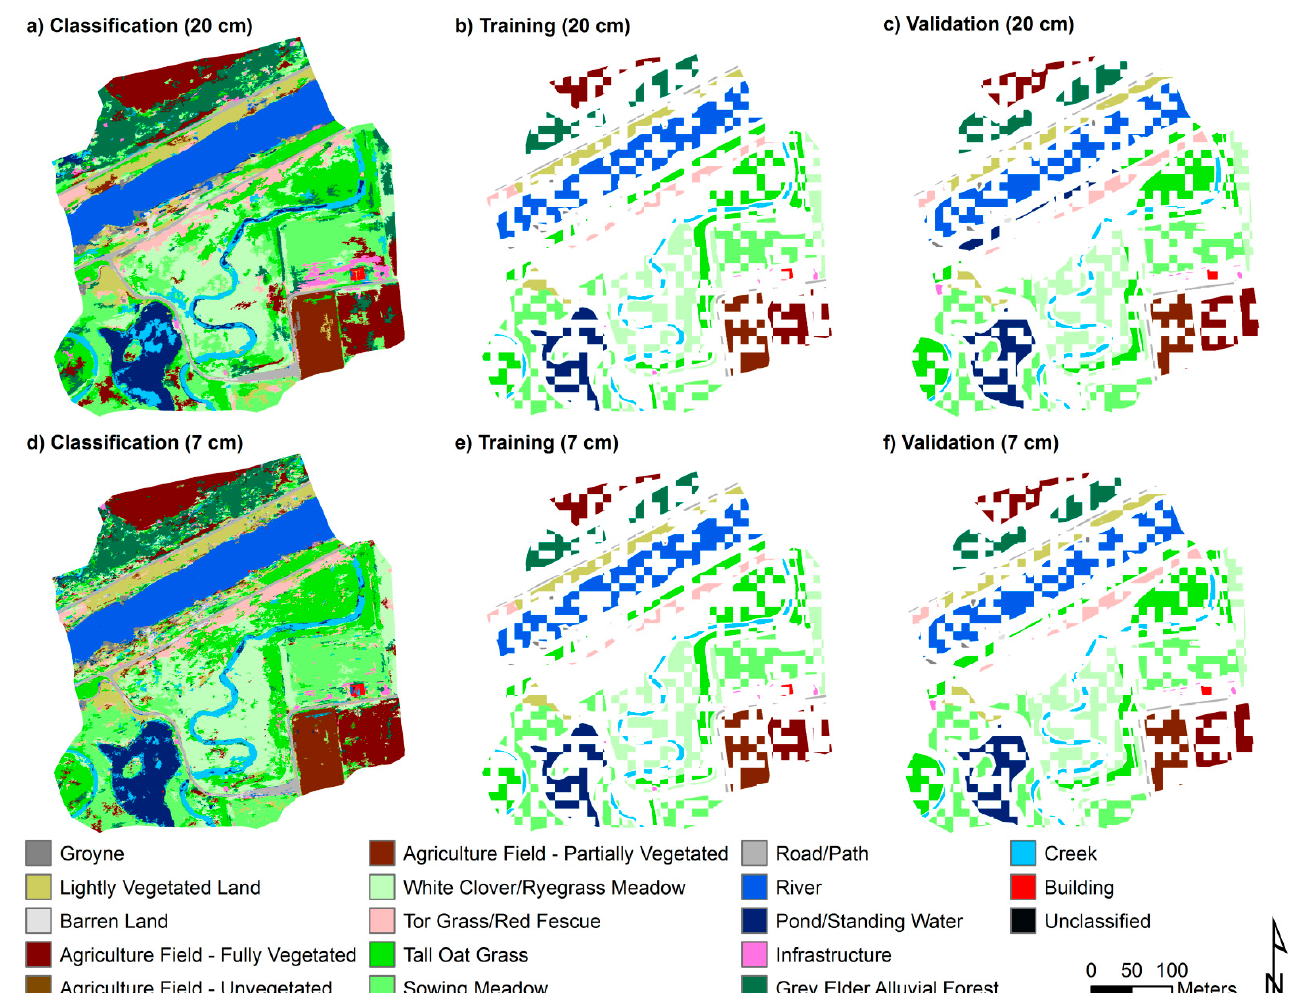
Figure 9. ( a ) Land cover classification of the 20 cm pixel size narrow-band 29 July 2016 image of the River Gail generated using eCognition ® ; ( b ) Training data used in eCognition ® for generating the land cover image in ( a ); ( c ) Validation data used in the accuracy assessment of the land cover image in ( a ); ( d ) Land cover classification of the 7 cm pixel size narrow-band 29 July 2016 image of the River Gail generated using eCognition ® ; ( e ) Training data used in eCognition ® for generating the land cover image in ( d ); ( f ) Validation data used in the accuracy assessment of the land cover image in ( d ).